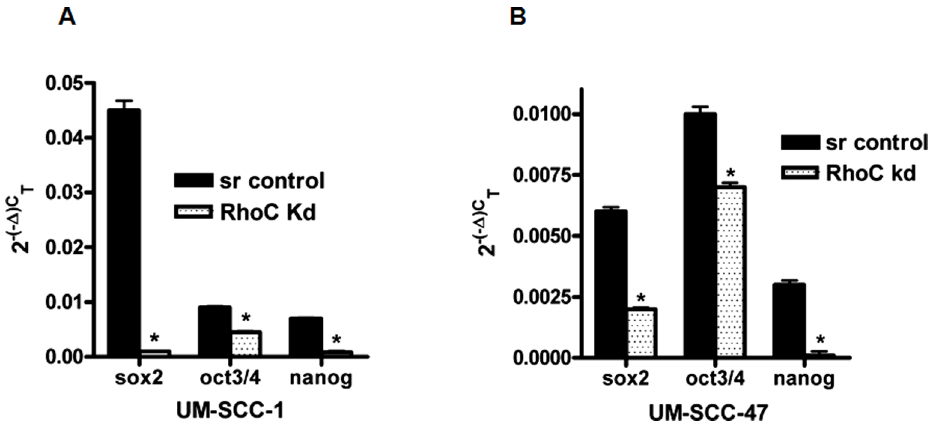
Figure 4. mRNA expression of stem cell transcription factors in scrambled control and RhoC knockdown HNSCC cell lines. Real time RT-PCR showing the mRNA expression of sox2, oct3/4 and nanog in adherent cells of UM-SCC-1(A) and-UM-SCC-47(B). A significant decrease in mRNA expression was observed in stem cell transcriptional factors in the RhoC knockdown HNSCC cell lines.